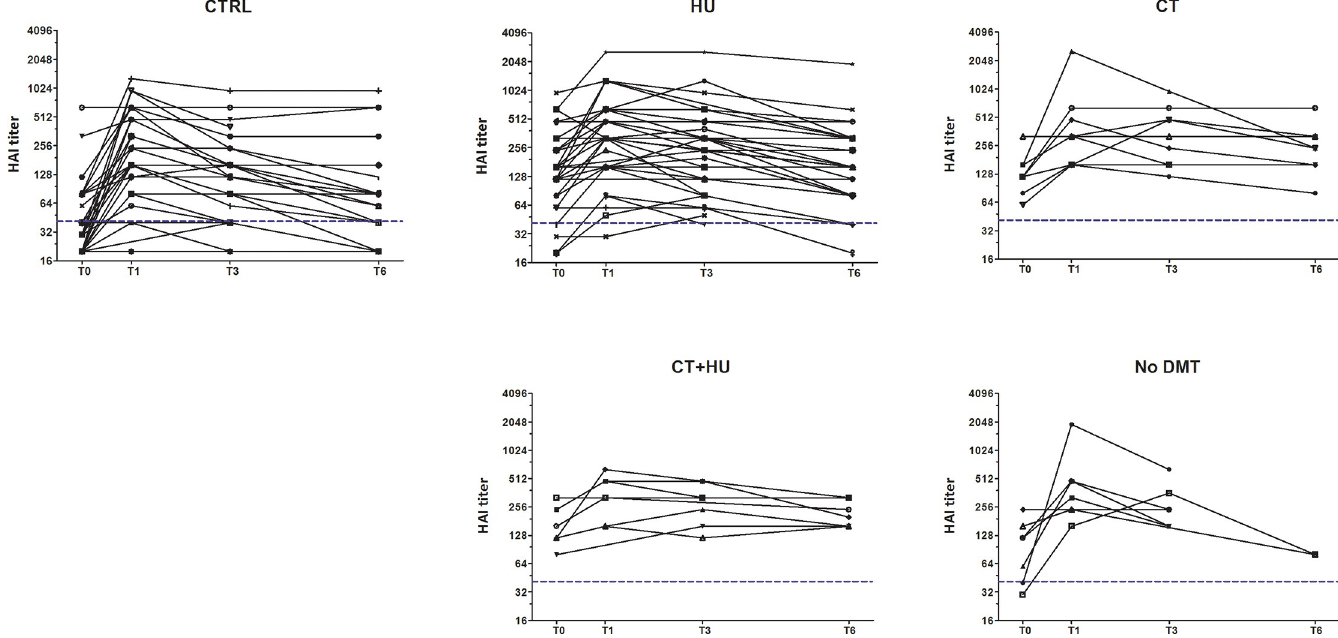
Fig 1. Kinetics of influenza HAI titers. Evolution of HAI titers measured at 0 (T0), 1 (T1), 3 (T3) and 6 (T6) months after vaccination for each subject. (A) Control group (B) SCD patients divided by treatment group. HU, hydroxyurea; CT, chronic transfusion; CT+HU both chronic transfusion and hydroxyurea; No DMT, No Disease modifying therapy. The dotted lines represent protective titer (1:40).